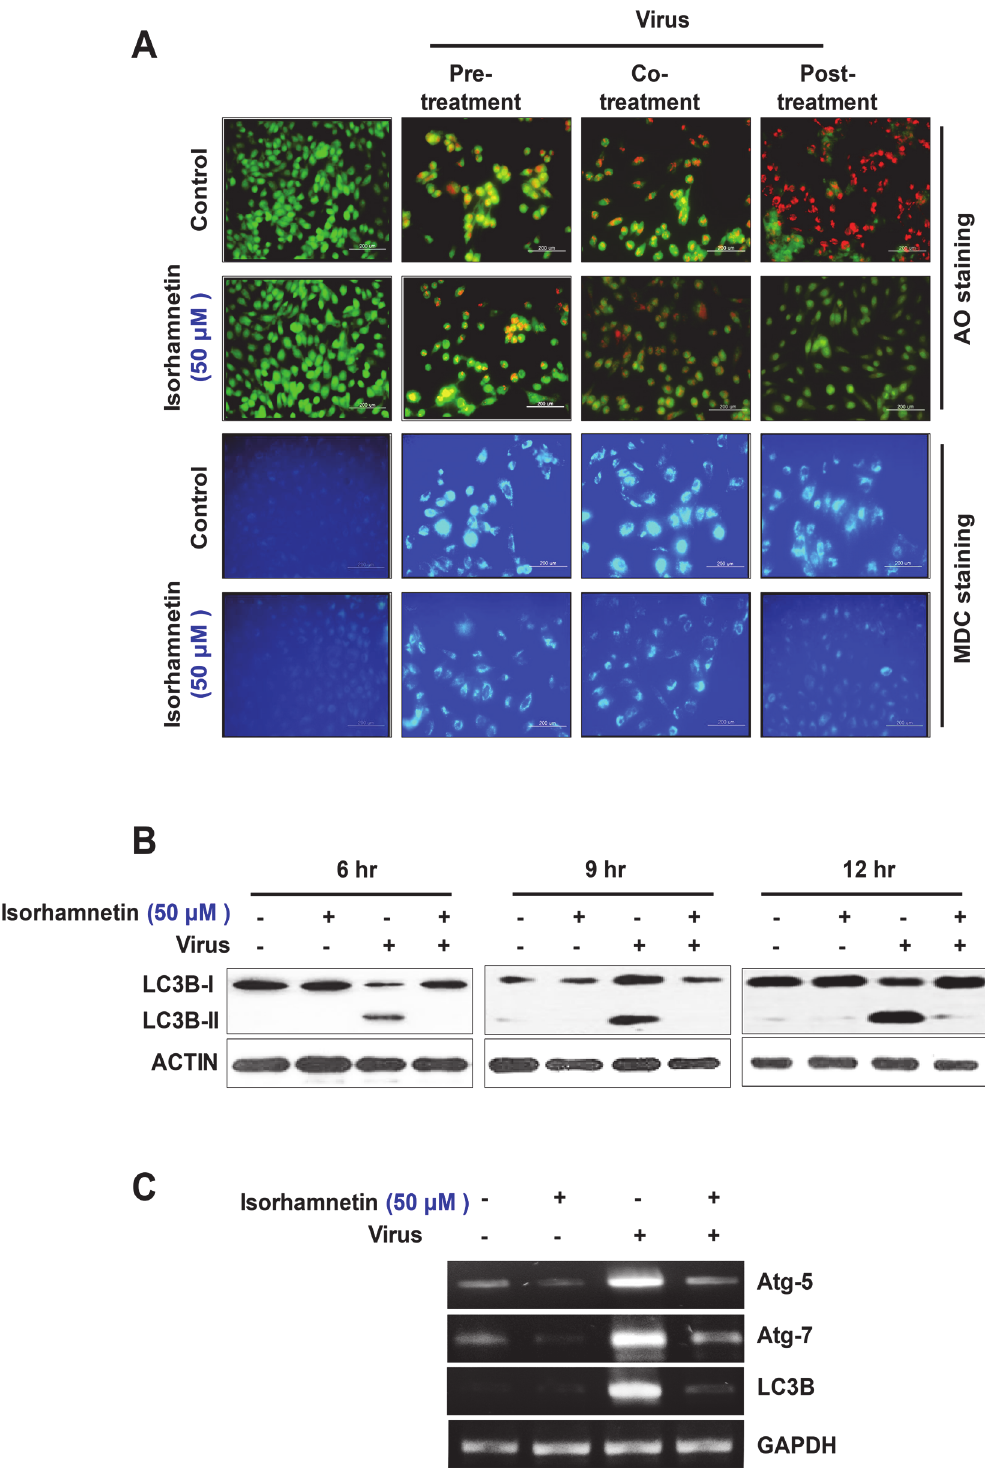
Fig 2. Effect of isorhamnetin treatment on the virus-induced autophagy. (A) Fluorescent microscope data for AVOs staining. MDCK cells were infected with the virus and then treated with isorhamnetin and finally stained with vital stains specific for AVOs (AO and MDC staining). (B) Western blot analysis for detection of LC3B protein lipidation. After infection with influenza A virus and treatment with isorhamnetin, we checked the lipidation of LC3B in a time- dependent manner (6 hr, 9 hr, and 12 hr). (C)RT-PCR data showing the expression level of autophagy genes. After virus infection and isorhamnetin treatment, we checked the expression level of autophagy related genes (Atg-5, Atg-7, and LC3B) using RT-PCR. Loading control = GAPDH. doi:10.1371/journal.pone.0121610.g002 PLOS ONE | DOI:10.1371/journal.pone.0121610 March 25,